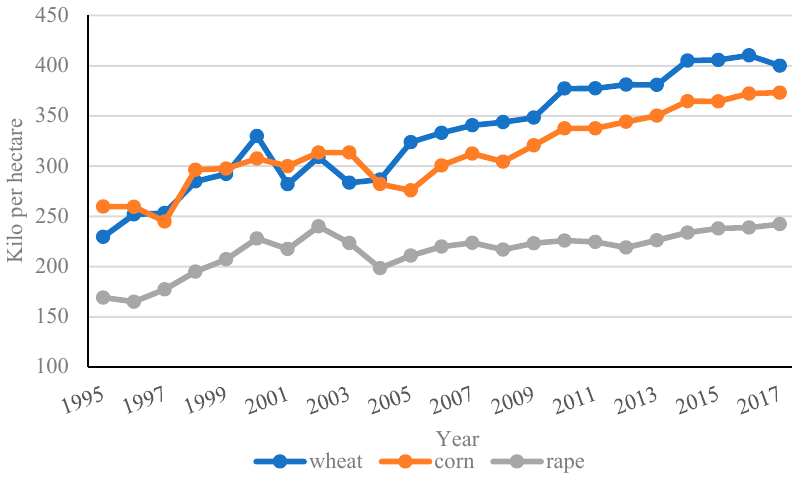
Figure 2. Chemical fertilizer input of widely planted crops in China, 1995 to 2017.